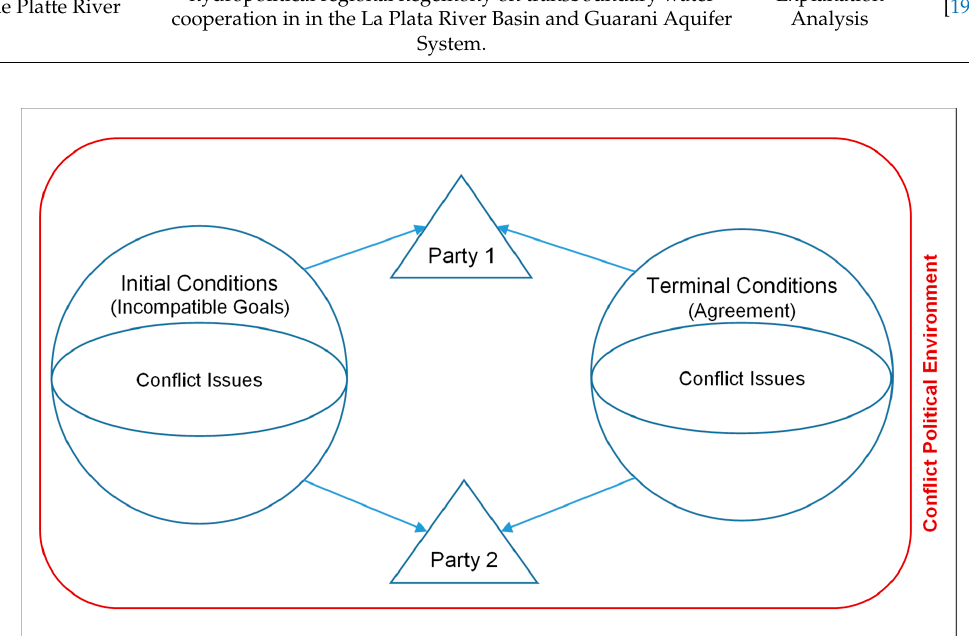
Figure 10. Structure of Political Mechanisms.